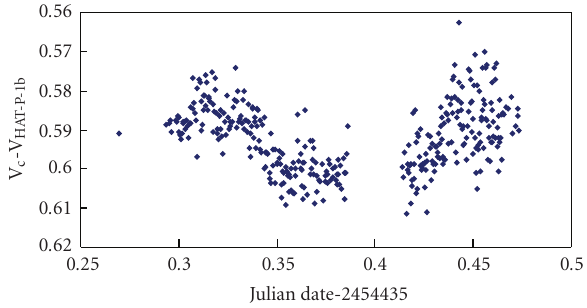
Figure 4: Transit light curve of the HAT-P-1b exoplanet obtained using the ICAT pipeline. 360 images were taken on November 30, 2007 at the OAdM, with the Johnson V filter. Calibration images were also taken and used for image correction. This figure also shows the instrumentation quality: a photometric dispersion of 0.4% is obtained at flat parts of the curve. Flat-fielding errors and scintillation are the main contributions to this dispersion, which is expected to be reduced up to a 0.2% when calibration tasks are finished. In contrast, the photon noise shows to have a smaller e ff ect. The increasing noise at the end of the observation is because the low altitude of the target. The gap during the transit was produced by an interruption of the observation